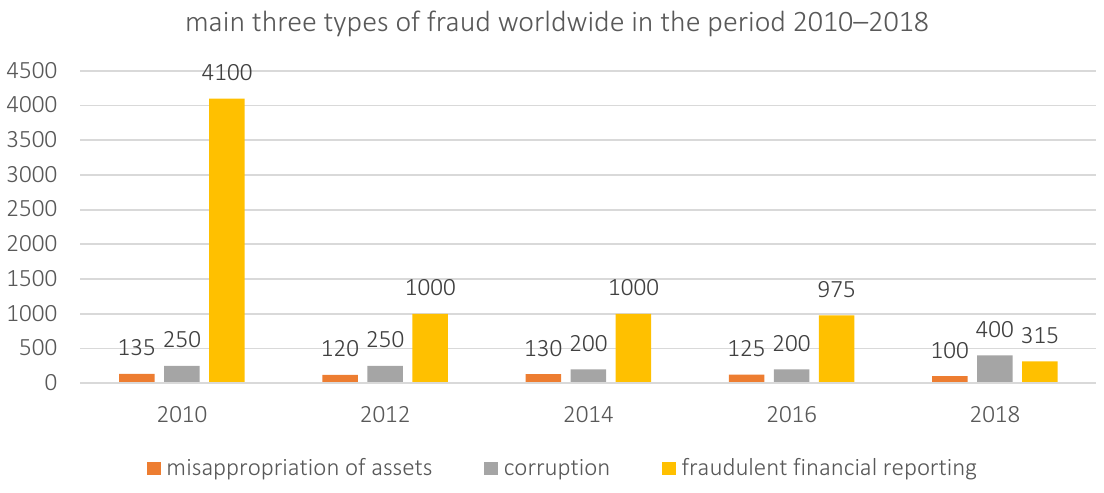
Figure 2. Losses due to economic fraud over the period